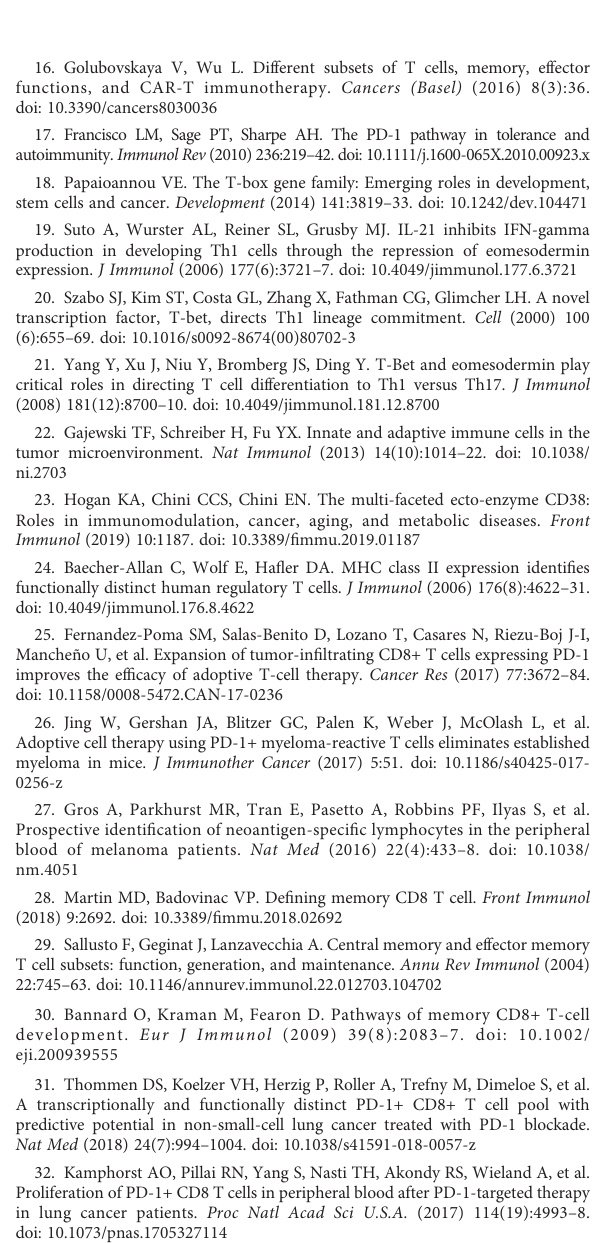
FIGURE S3 Dynamic expressions of Eomes, T-betand IFN- g in PD-1+ andPD-1- CD8 +T-cell subsets. (A) PD-1+CD8+ Tcells in RTplus immunotherapy group. (B) PD-1-CD8+ T cells in RT plus immunotherapy group. (C) PD1+CD8+ T cells in CCRT group. (D) PD1-CD8+ T cells in CCRT group.